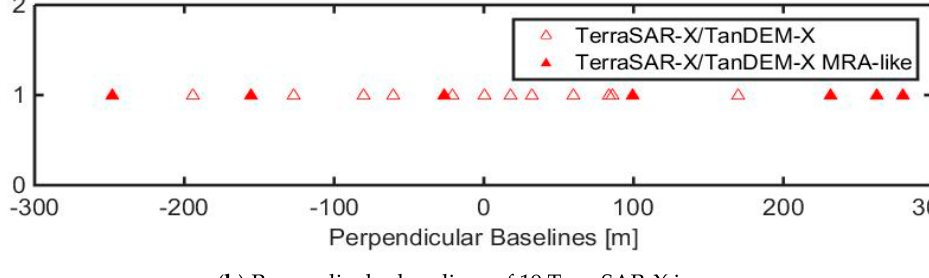
Figure 9. Perpendicular baselines of COSMO-SkyMed and TerraSAR-X/TanDEM-X images.